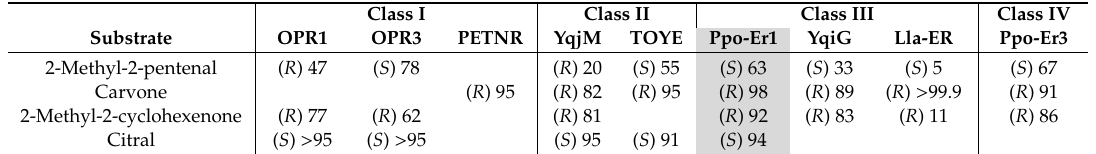
Table 3. The enantiomeric excess of some selected OYEs (YqiG [15], Lla-Er [15], Ppo-Er3 [15], OPR1 [54], OPR3 [54], PETNR [50], YqjM [54], TOYE [23]) from classes I–IV. The values presented for YqjM were measured as a reference for Ppo-Er1 and compared with the literature